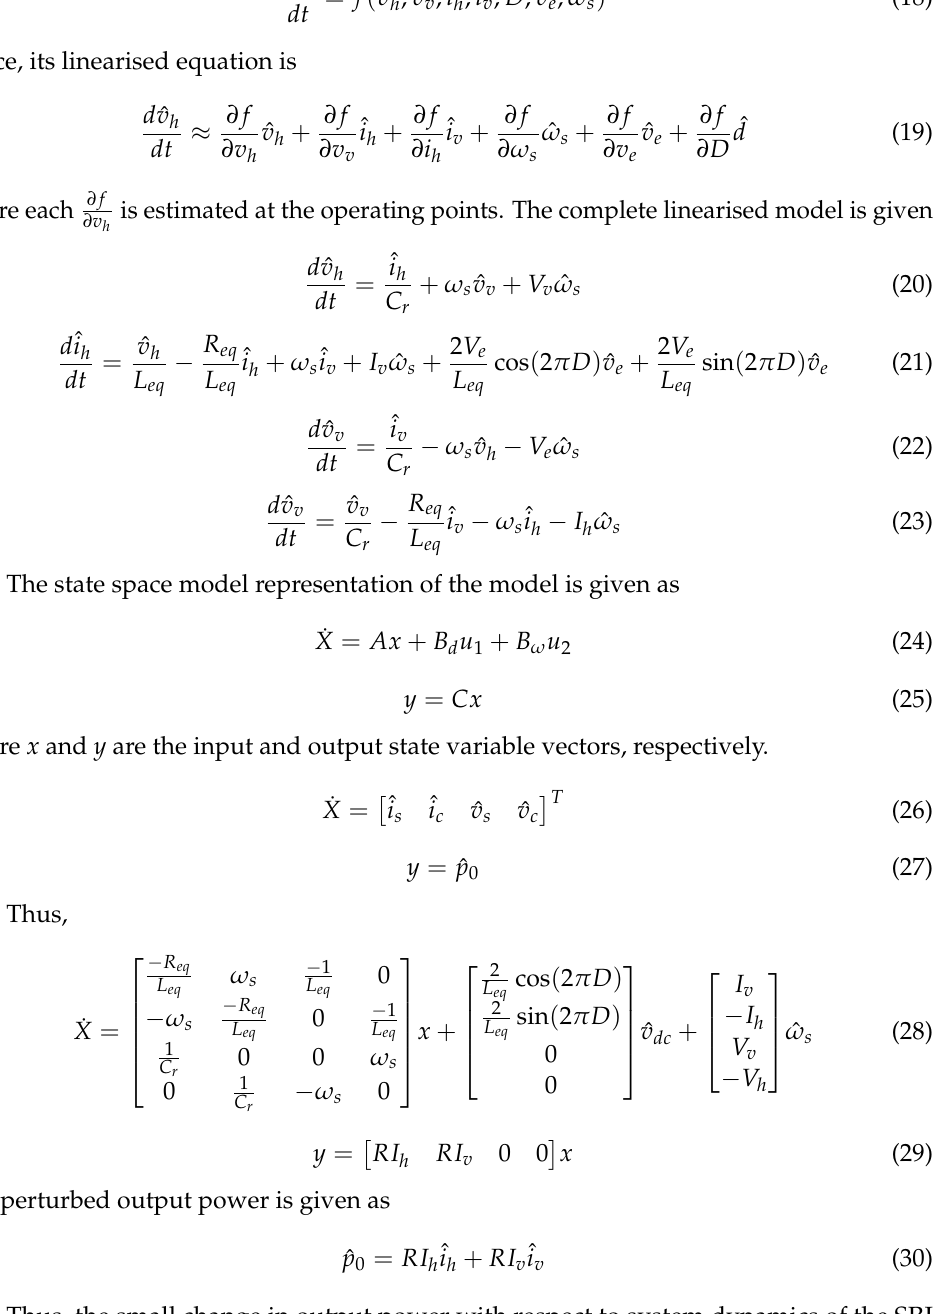
resonant inverter [40,45–47], a half-bridge (HB) inverter [5,20,43,48–52] and a full-bridge (FB)